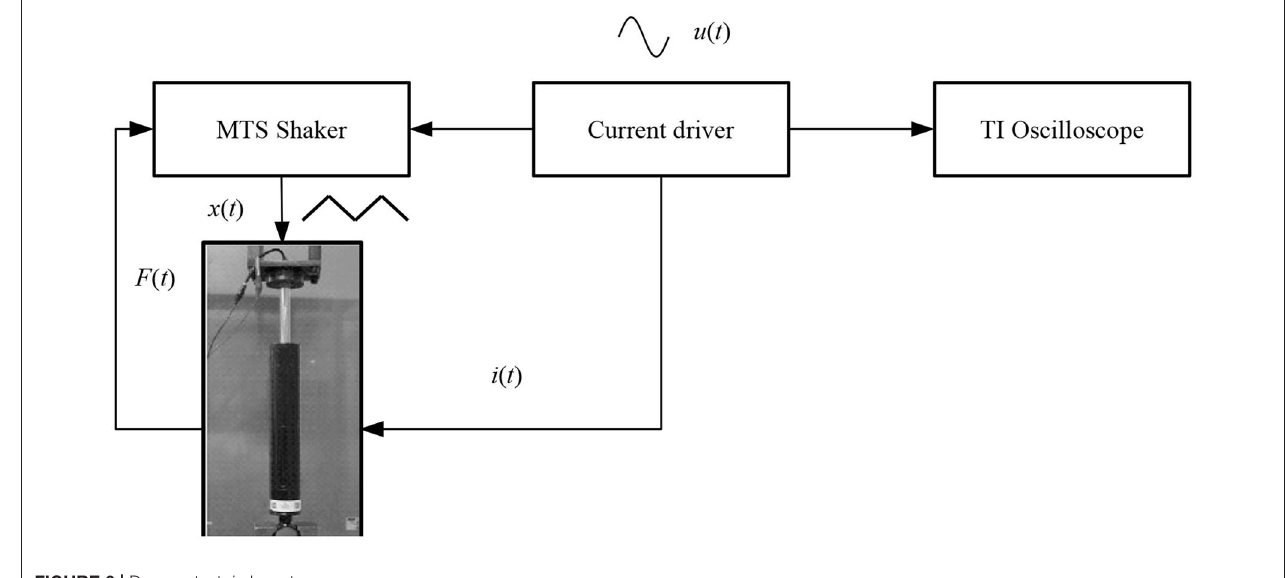
FIGURE 6 | Damper test rig layout.